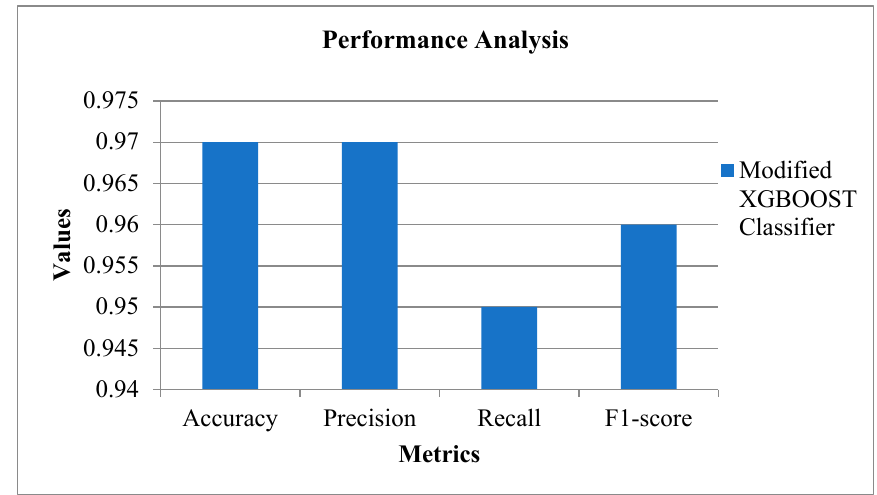
Figure 14. Performance metrics of the Modified XGBoost Classifier.